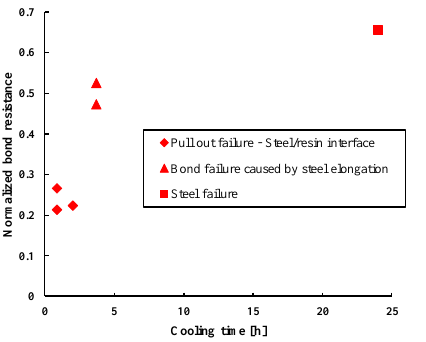
Figure 3. Post-fire pull-out normalized resistances at different cooling times.